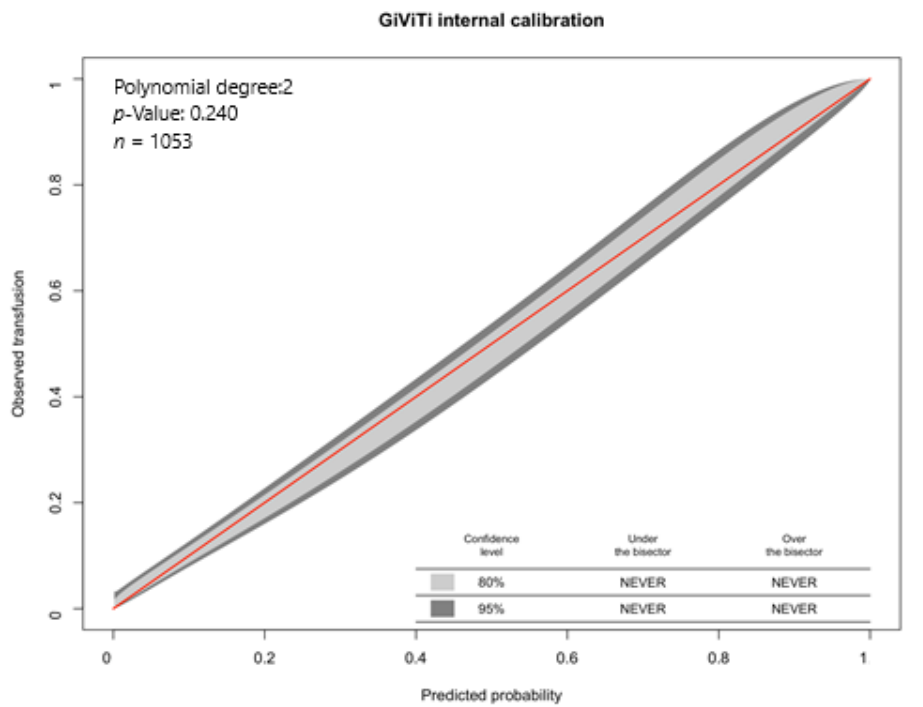
Figure A1. Gruppo Italiano per la valutazione degli interventi in Terapia Intensiva (GiViTi) internal calibration.